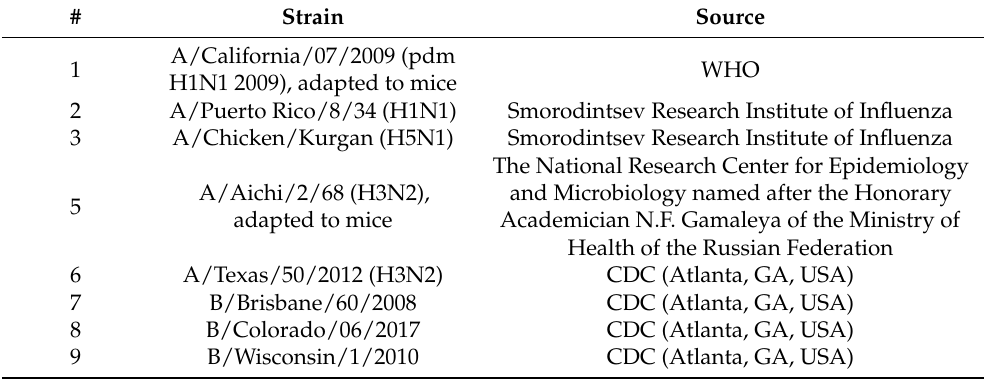
Table A2. The following viruses were used to perform the hemagglutination inhibition (HAI) test and neutralization